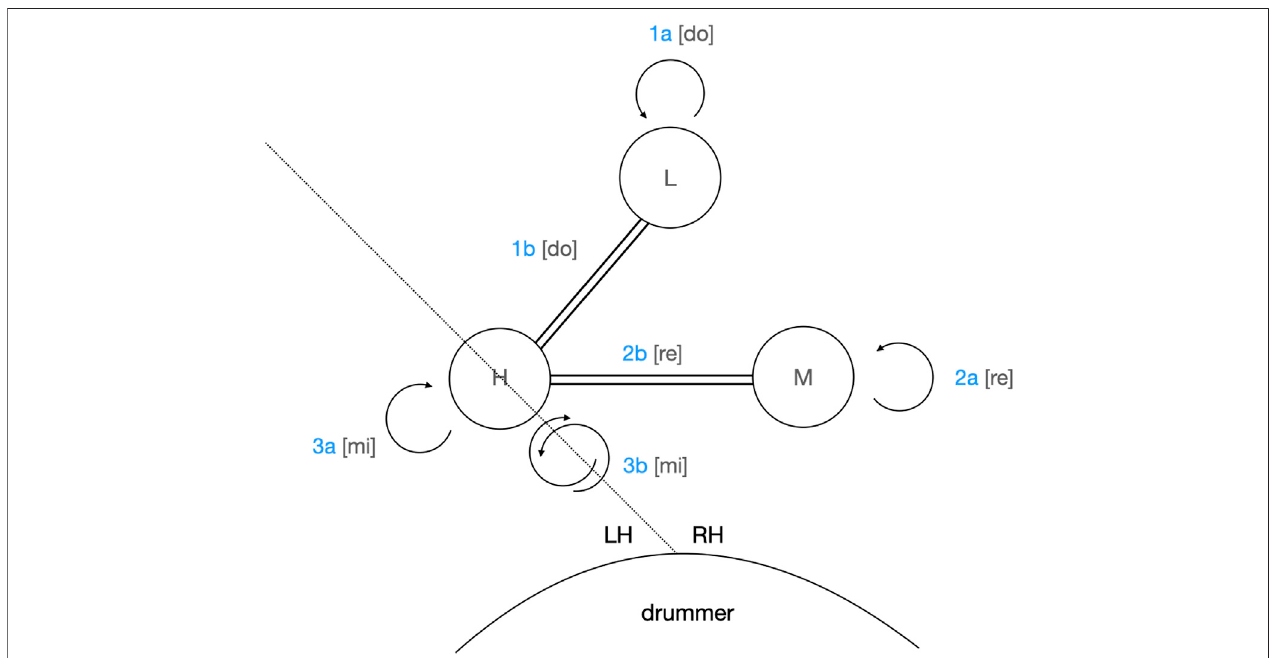
FIGURE 9 | Graphic representation of the omele bàtá speech surrogacy